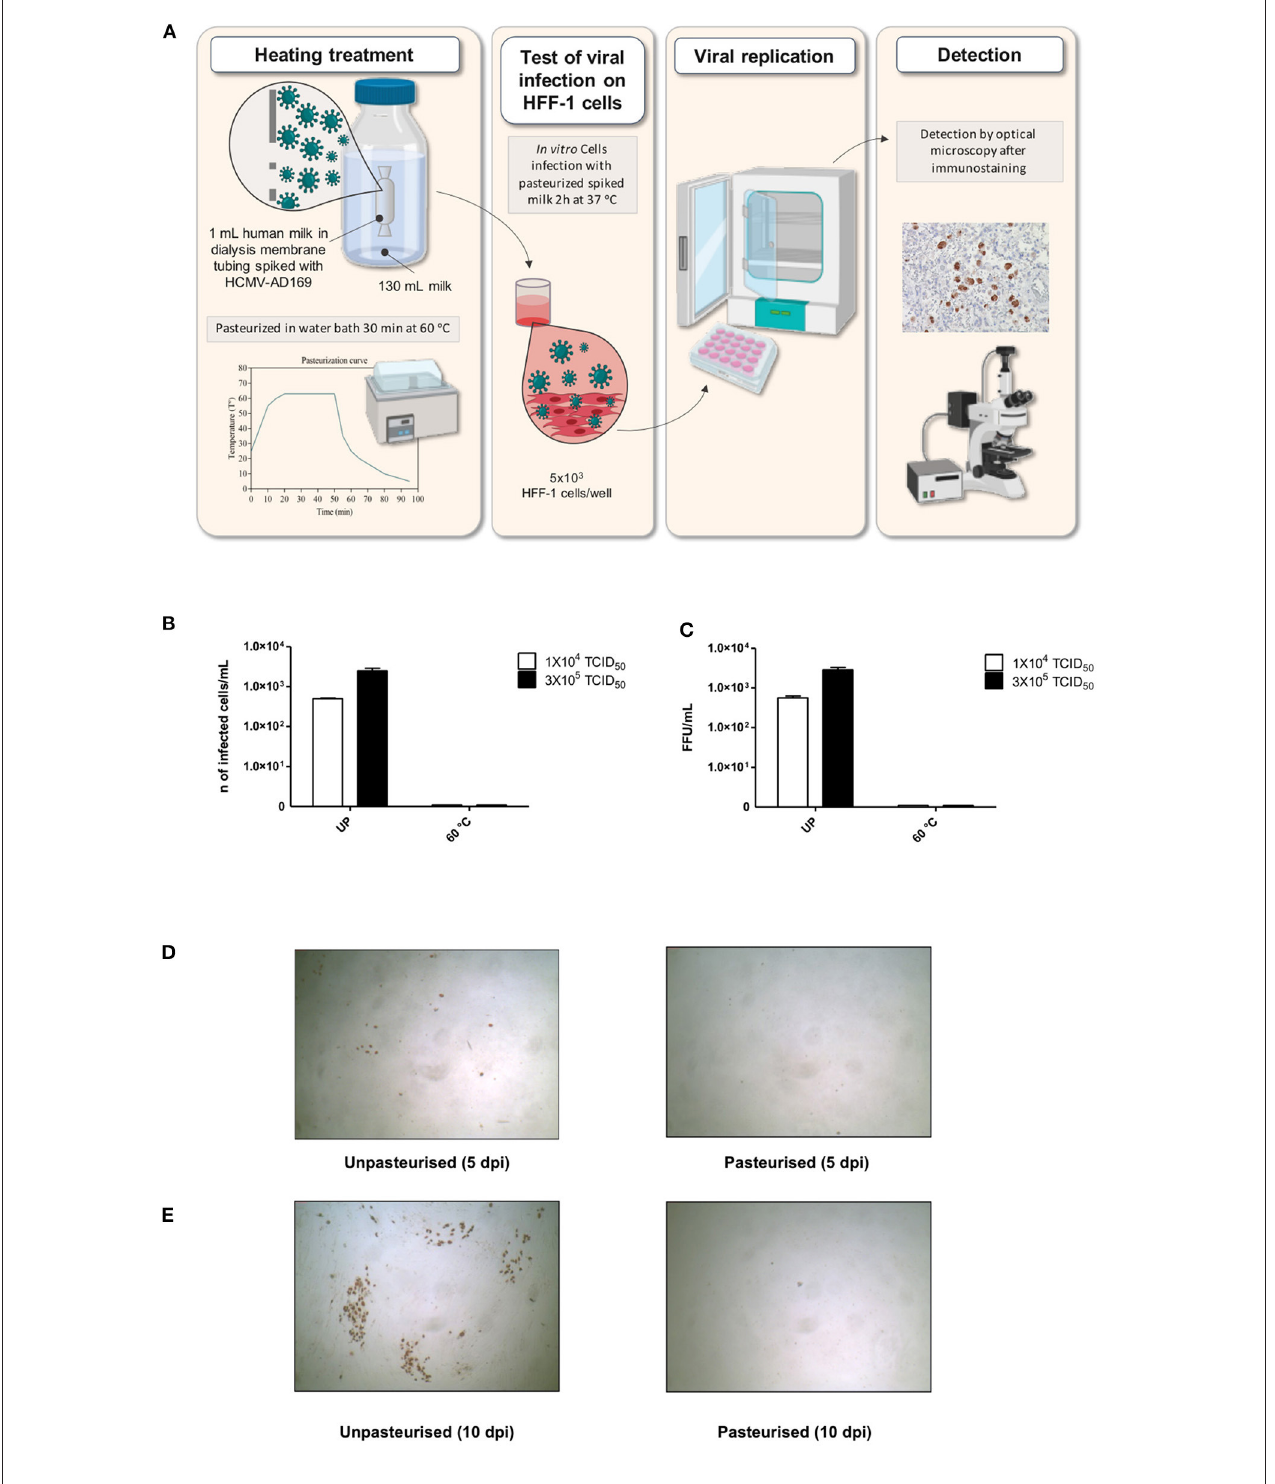
FIGURE 1 | Effects of treatment at 60 ◦ C for 30min on HCMV strain AD169 infectivity at two different titers in a pasteurizer-like model. (A) Heat treatment and infection protocol for HCMV. (B,C) In the graphs, HCMV infectivity of heat-treated milk samples spiked with HCMV AD169 at two titers (1 × 10 4 TCID50 and 3 × 10 5 TCID50) is reported as number of infected cells/ml at 5 days post infection (B) and as FFU/ml at 10 days post infection (C) . (D,E) . Representative figures of HFF-1 cells treated with milk samples spiked with HCMV (3 × 10 5 TCID50) and treated at 4 ◦ C for 30min (unpasteurised, left) or at 60 ◦ C for 30min (pasteurized, right) at 5 days post infection (D) and 10 days post infection (E) . Infected cells and foci are brown by immunostaining. UP, unpasteurised.